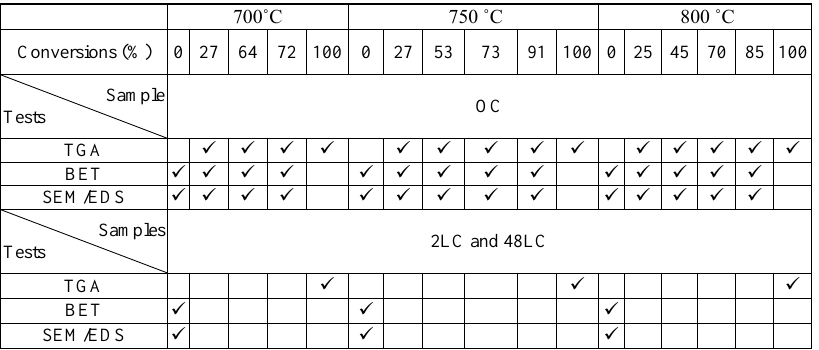
Table 2. Summary of experiments and analyses.